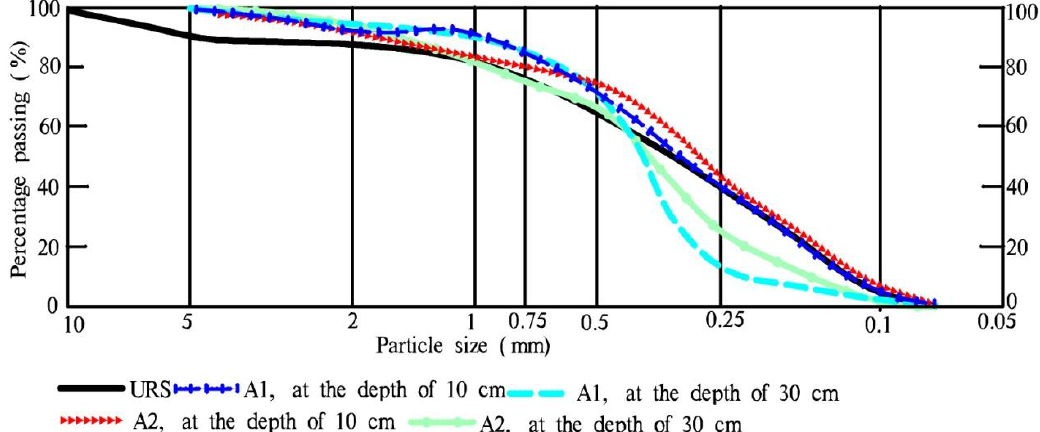
Figure 11. Accumulative curve of particle gradation of soil with overlaying soil thickness of 30 cm (A1 and A2).